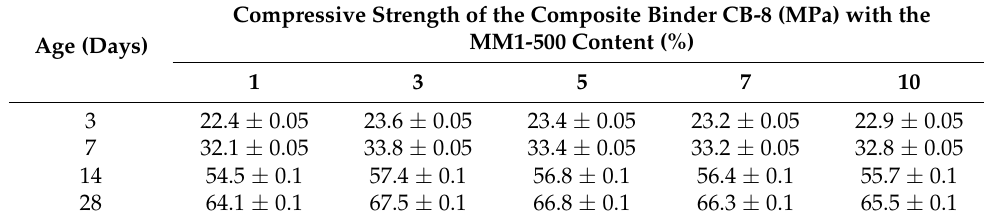
Table 11. Compressive strength gain kinetics for composite binder specimens. Compressive Strength of the Composite Binder CB-8 (MPa) with the Age (Days)